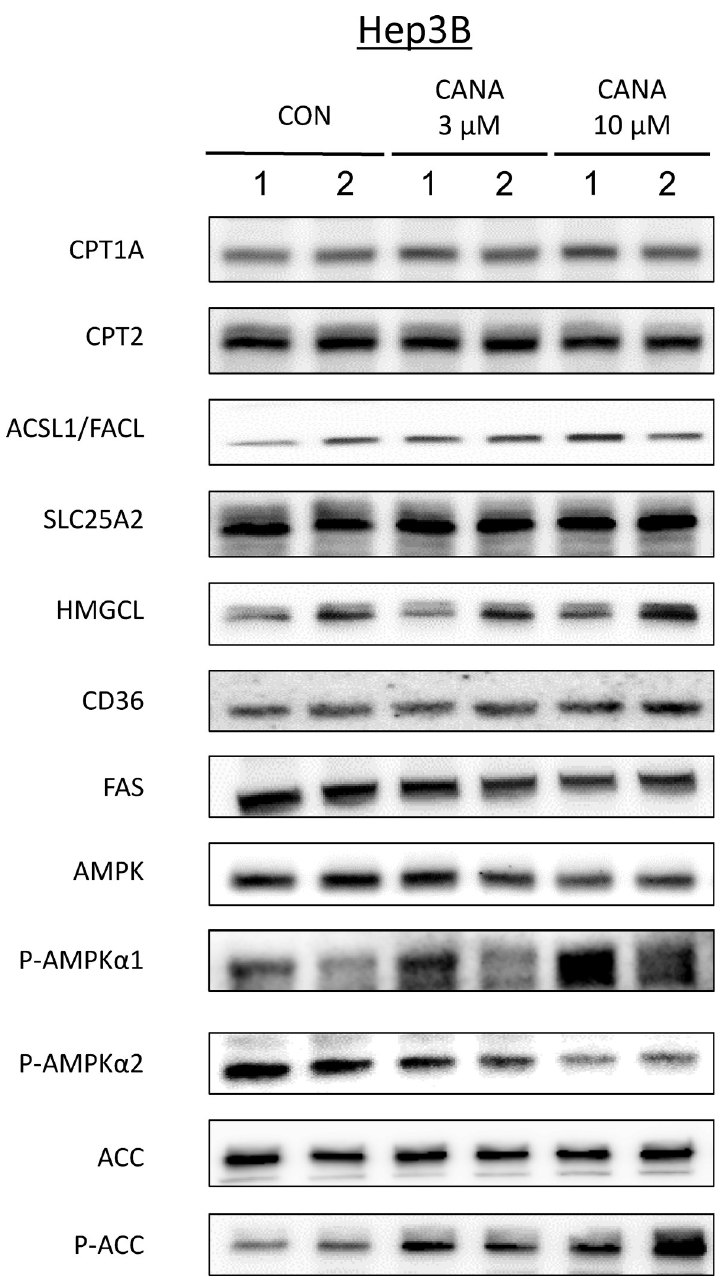
Fig 6. Effect of CANA on fatty acid metabolism-associated molecules. Expression of fatty acid metabolism- associated molecules was evaluated by immunoblotting 48 hours after treatment with CON, 3 μ M CANA, and 10 μ M CANA. Abbreviations: CPT, carnitine palmitoyltransferase; ACSL/FACL, acyl-CoA synthetase long-chain family member/fatty acid-CoA ligase; SLC25A2, solute carrier family 25 member 2, hydroxymethylglutaryl-CoA lyase; HMGCL, hydroxymethylglutaryl-CoA lyase; FAS, fatty acid synthase; AMPK, AMP-activated protein kinase; ACC, acetyl-CoA carboxylase. AMPK α 2 was significantly downregulated in the CANA 10 μ M group compared to the CON group. No significant difference was seen in the protein expression level of ACC between the two groups; however, p-ACC was significantly upregulated in the CANA 10 μ M group